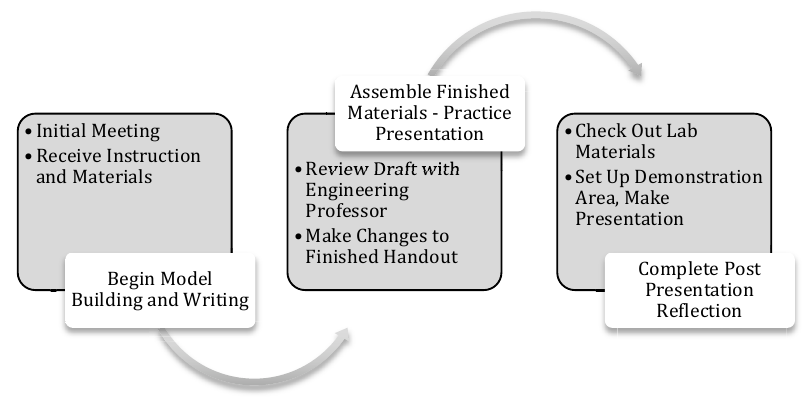
Fig. 2. Activity record describing students’ actions in chronological order, including steps taken by students to complete their project from start to finish. Gray boxes represent scaffolding by the researcher and/or professor. White boxes represent student independent work